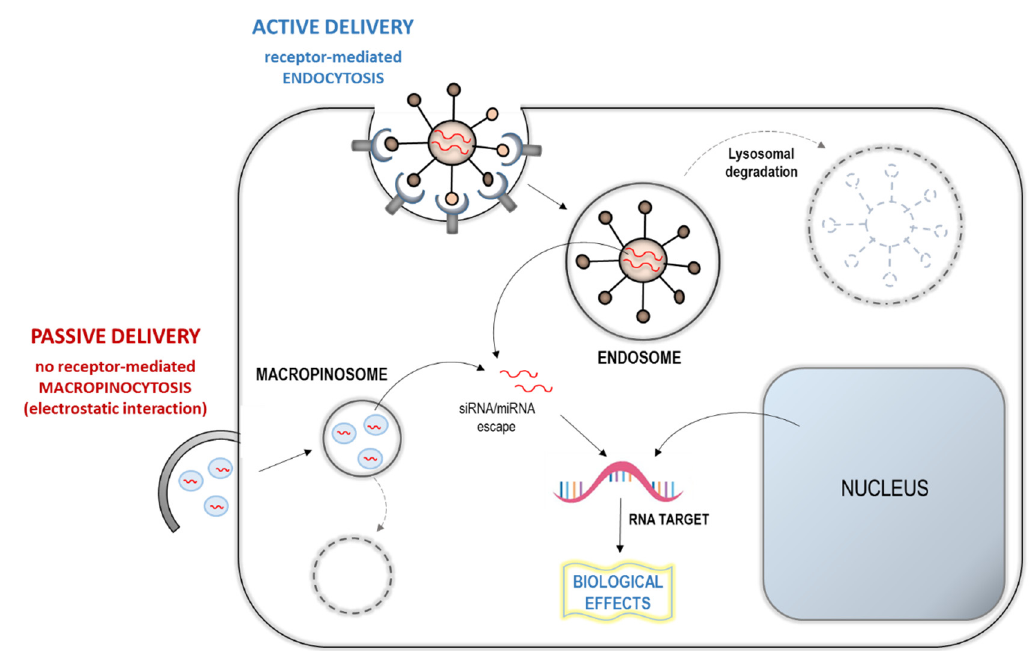
Figure 3. Micro-RNA/small interference-RNA (miRNA/siRNA) delivery strategies: (1) Active: By receptor-mediated endocytosis (as in the figure), or conjugated to cholesterol, aptamers, membrane- penetrating polymers, etc. and (2) passive: By no receptor-mediated micropinocytosis of miRNA/siRNA-carrying nanoparticles, liposomes-like particles, etc. by electrostatic interaction with a cellular membrane.